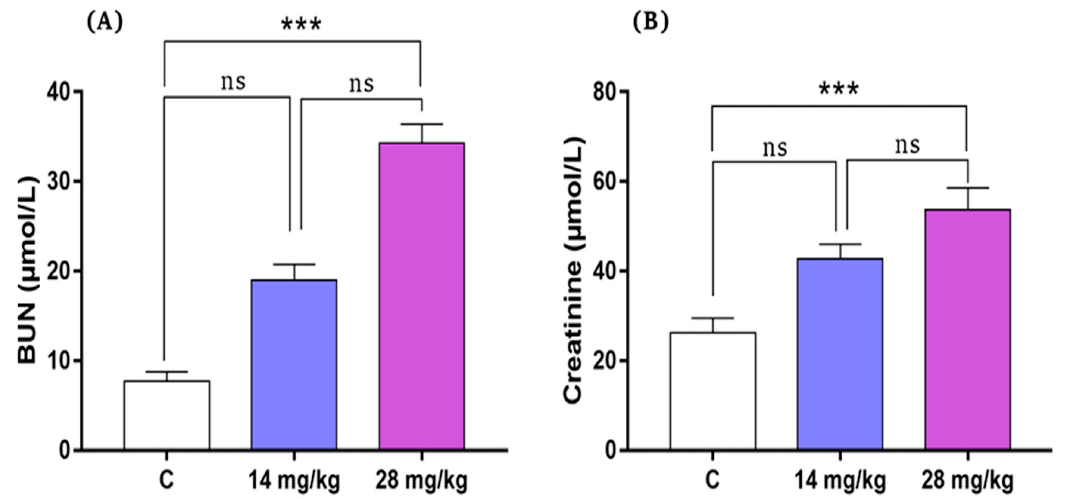
Figure 2. Variations in plasmatic BUN ( A ) and creatinine ( B ) levels in the control and treatment group rats ( n = 8/group). Values are expressed as mean ± standard deviation (SD). *** p < 0.001, significant differences compared with controls. BUN, blood urea nitrogen; ns, non ‐ significant.